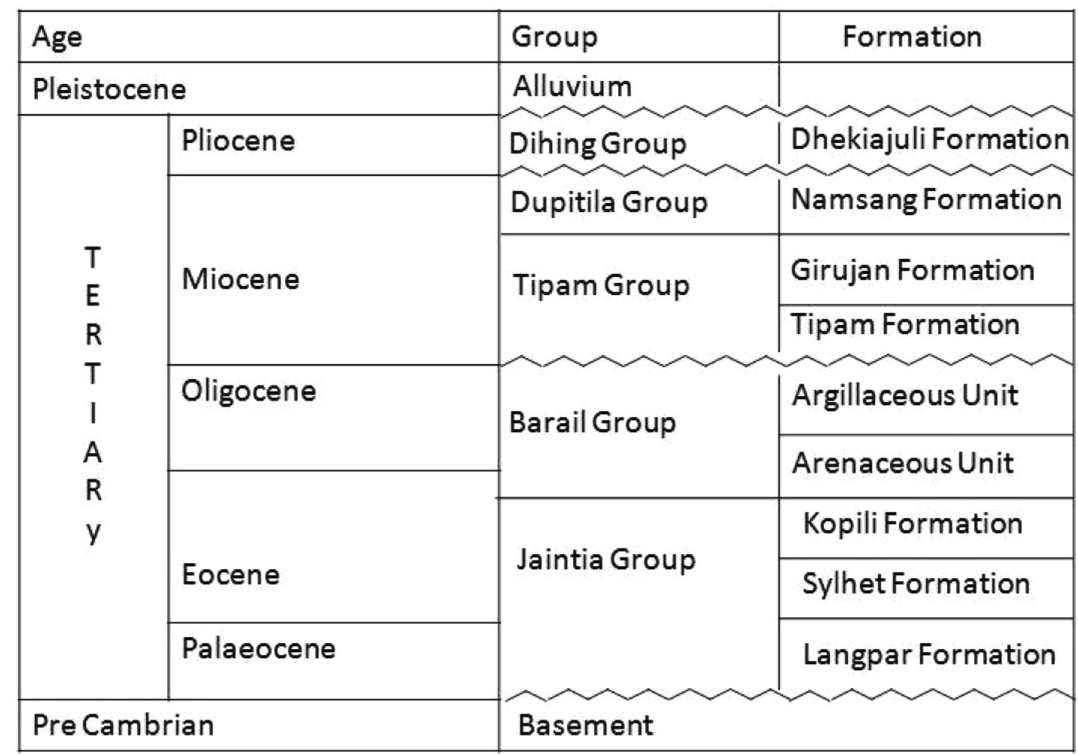
Fig. 2 Generalized stratigraphic formation of the upper Assam-Arakan basin. (After Sekhar Deb and Barua